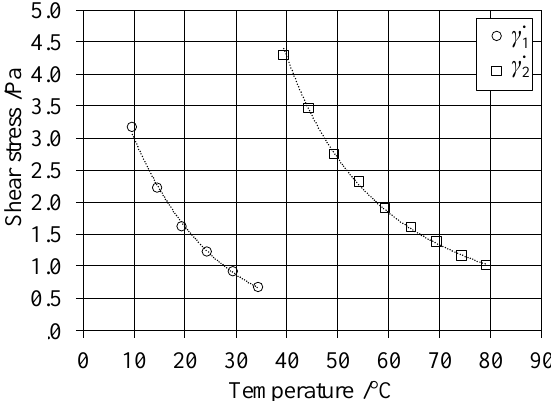
Fig. 3. Dependence of the oil shear stress τ O on the temperature t O , the shear rates are γ̇ 1 = 13.03 s -1 and γ̇ 2 = 102.37 s -1 .